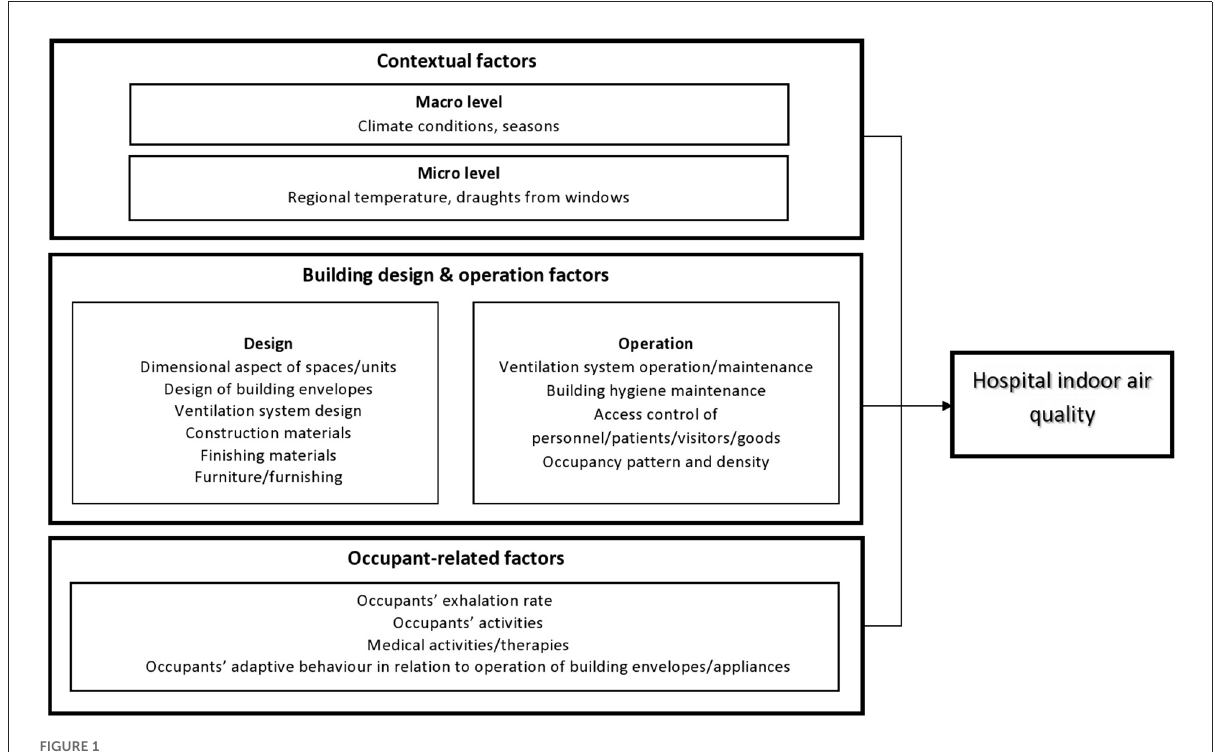
FIGURE1 Determinants of hospital indoor air quality based on previous